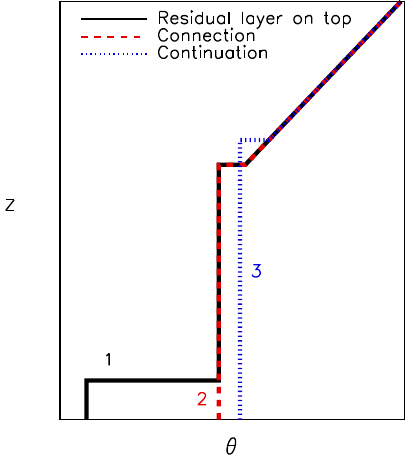
Fig. 2. Vertical potential temperature profiles during a transition Fig. 12. Vertical potential temperature profiles during a transition from a mixed boundary layer topped with a residual boundary layer to from a mixed boundary layer topped with a residual boundary layer acombined ABL.Initially (1) ashallow boundary layer develops under theinfluence of surface heat fluxes.Whenthepotential temperatures in thislayer and in theresidual layer areequal, both layersconnect (2) . After both layersare connected, the combined ABLfurther develops to a combined ABL. Initially (1) a shallow boundary layer devel- as usual (3) . ops under the influence of surface heat fluxes. When the potential temperatures in this layer and in the residual layer are equal, both layers connect (2) . After both layers are connected, the combined ABL further develops as usual (3)